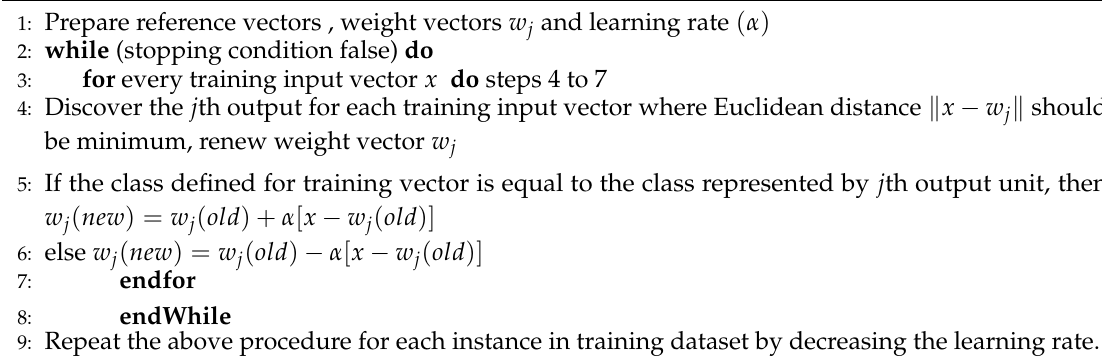
Algorithm 3 Procedure to implement learning vector quantization